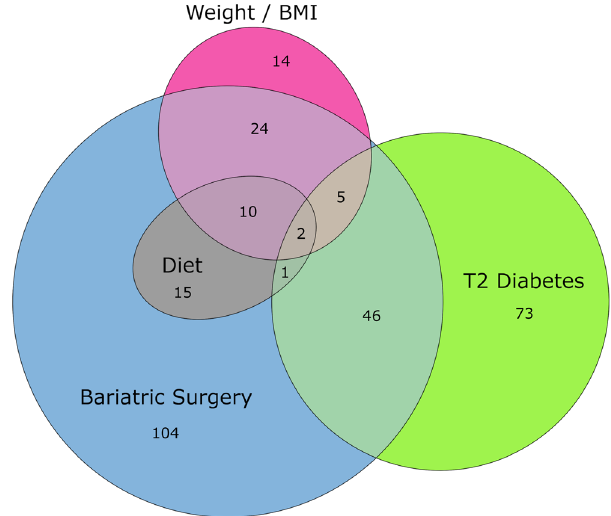
Fig. 2 Metabolites associated with bariatric surgery, body mass index and glycaemic control. Euler diagram of identi fi ed metabolites associated with bariatric surgery, weight / body mass index (BMI), type 2 diabetes (T2D) and diet. Diagram shows identi fi ed metabolites from serum, urine and faecal bio fl uids with associations (pFDR < 0.05) to (1) post- versus pre- bariatric surgery, (2) lower weight / BMI, (3) lower glycated haemoglobin (HbA1c) / non-T2D Vs T2D, (4) lower dietary substrate / higher Alternative Healthy Eating Index (AHEI-2010) score. Metabolites with concordant changes are grouped together. Metabolites from each grouping and their associations are detailed in Supplementary Data